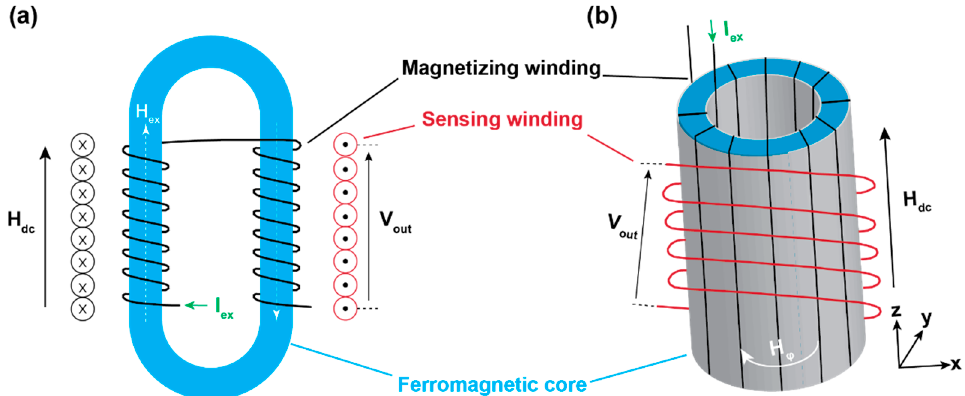
Figure 1. The schematical diagram of: ( a ) parallel fluxgate magnetic sensor and ( b ) orthogonal fluxgate magnetic sensor. The word “parallel” and “orthogonal” in the name mean the orientation between the excitation magnetic field and the probed magnetic field. In ( a ), the excitation magnetic field H ex is parallel to the probed magnetic field H dc . In ( b ), the excitation current is along the axial direction. So, the excitation magnetic field is around the circle and orthogonal to the probed field H dc . Only the orthogonal fluxgate sensor needs the DC exciting current which should be sufficiently larger than the AC exciting current.